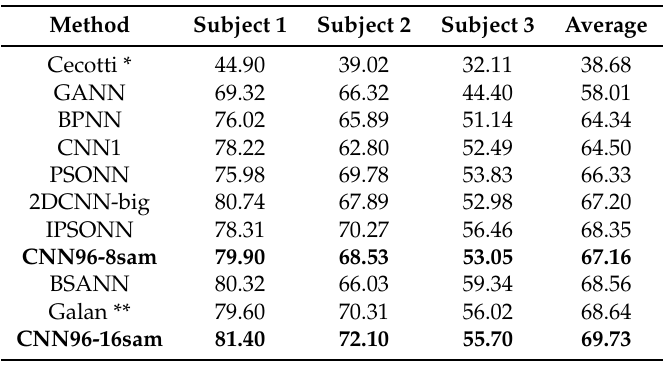
Table 8. Effectiveness comparison of the ANN-based methods (in %). The Cecotti * row presents the results obtained using Cecotti’s architecture and feeding. The Galan ** row presents the results obtained by the statistical discrimination-based method that won the international BCI Competition III.